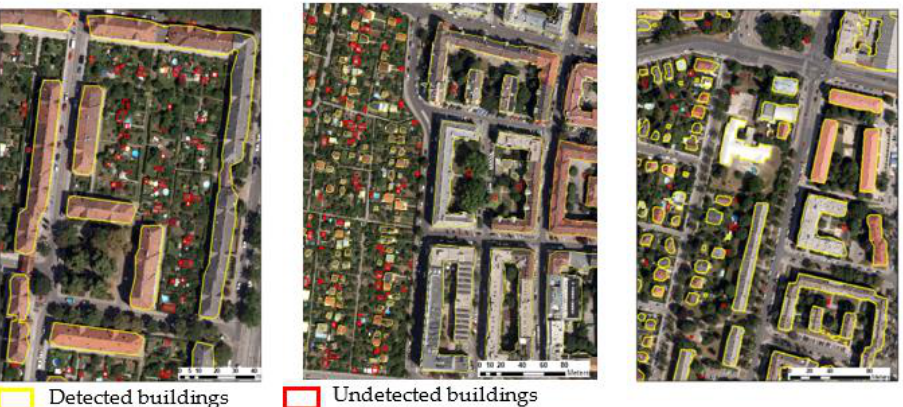
Figure 16. Undetected buildings from the proposed model due to the building size becoming minor.